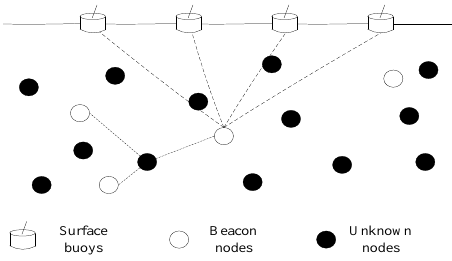
Figure 1. Schematic diagram of the monitoring model of an UWSN.